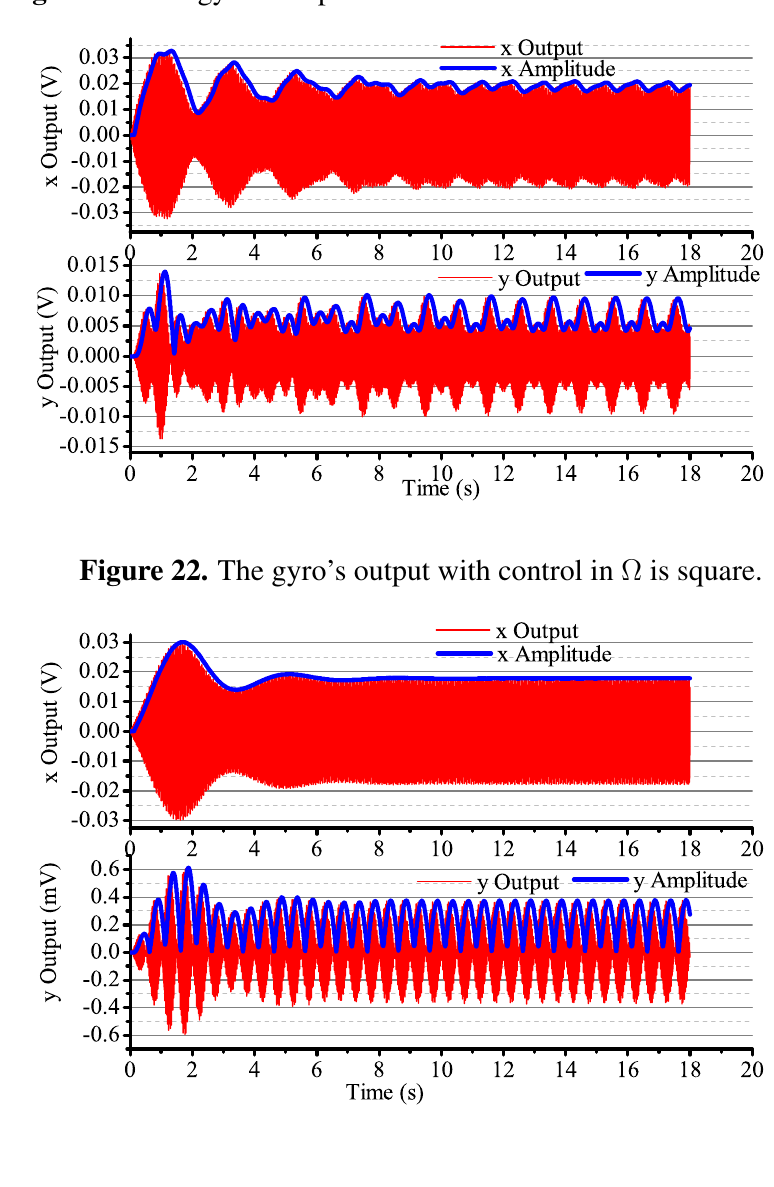
Figure 21. The gyro’s output with non-control in Ω is the sine signal.